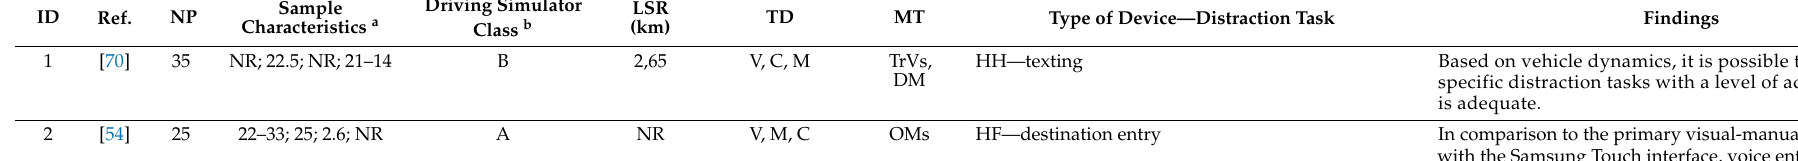
Table 1. An overview of driving simulators characteristics and classification ( n =